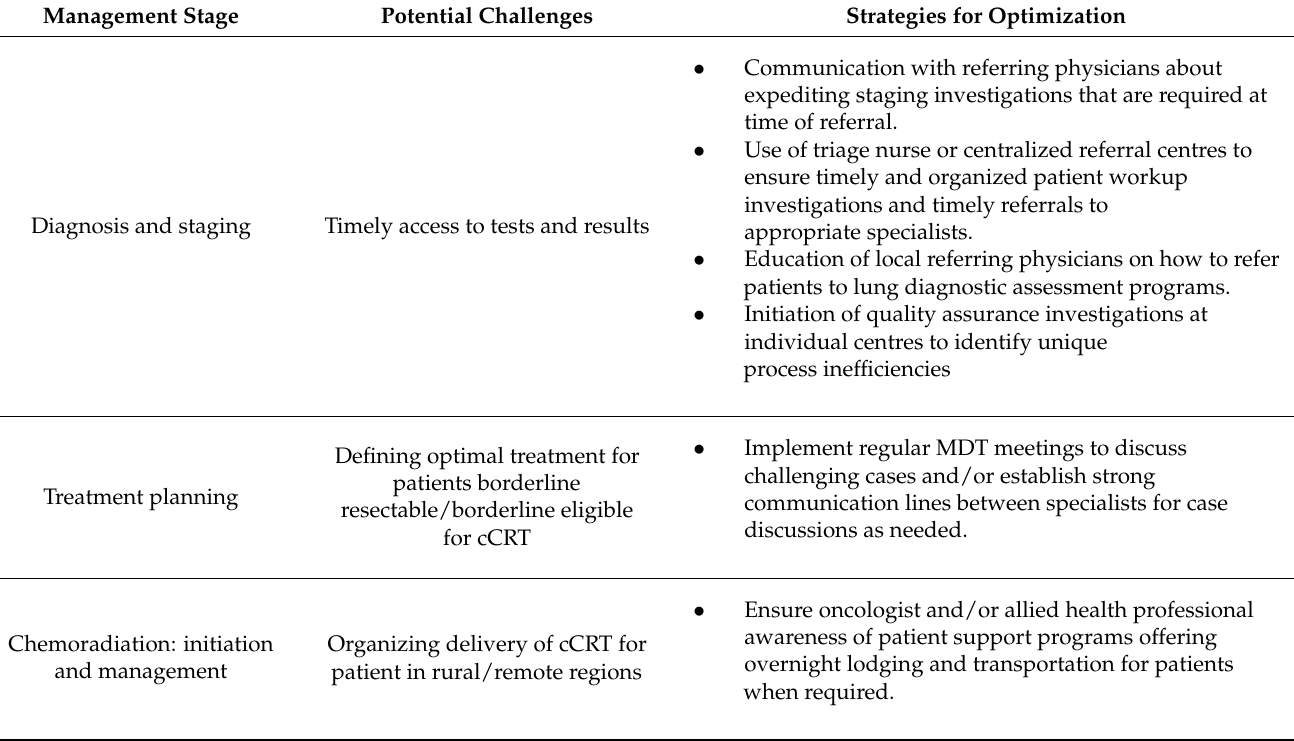
Table 1. Challenges and strategies for optimizing clinical care for patients with stage III unresectable NSCLC. Management